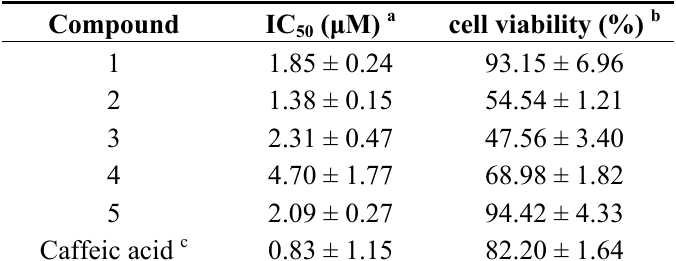
Table 2. Inhibitory effects of compounds 1 – 5 against LPS-Induced NO production in RAW 264.7 macrophage